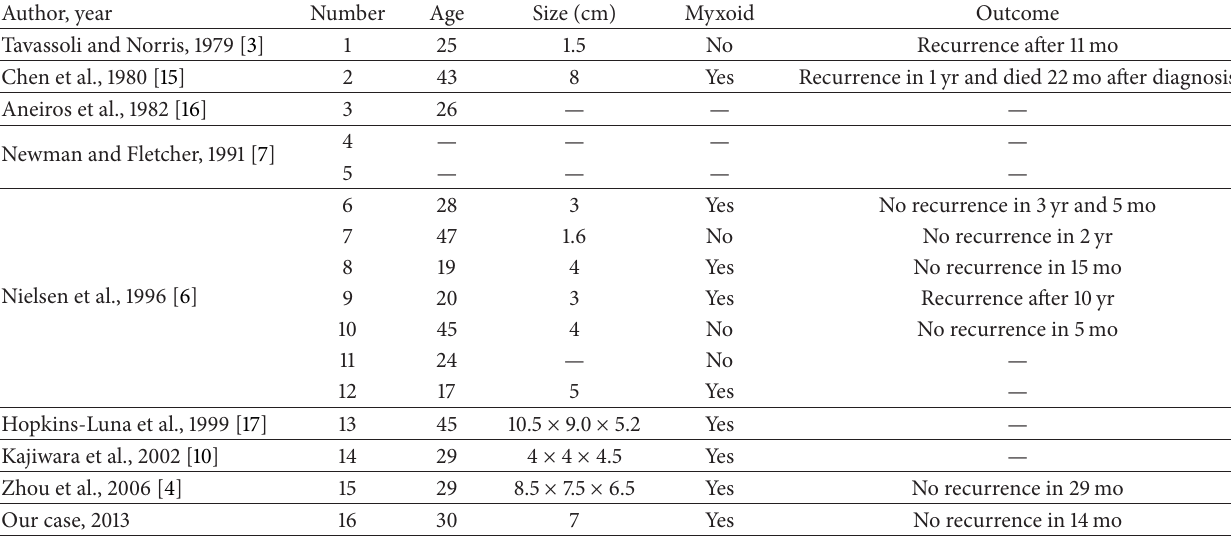
Table 1: A summary of the epithelioid leiomyomas of the